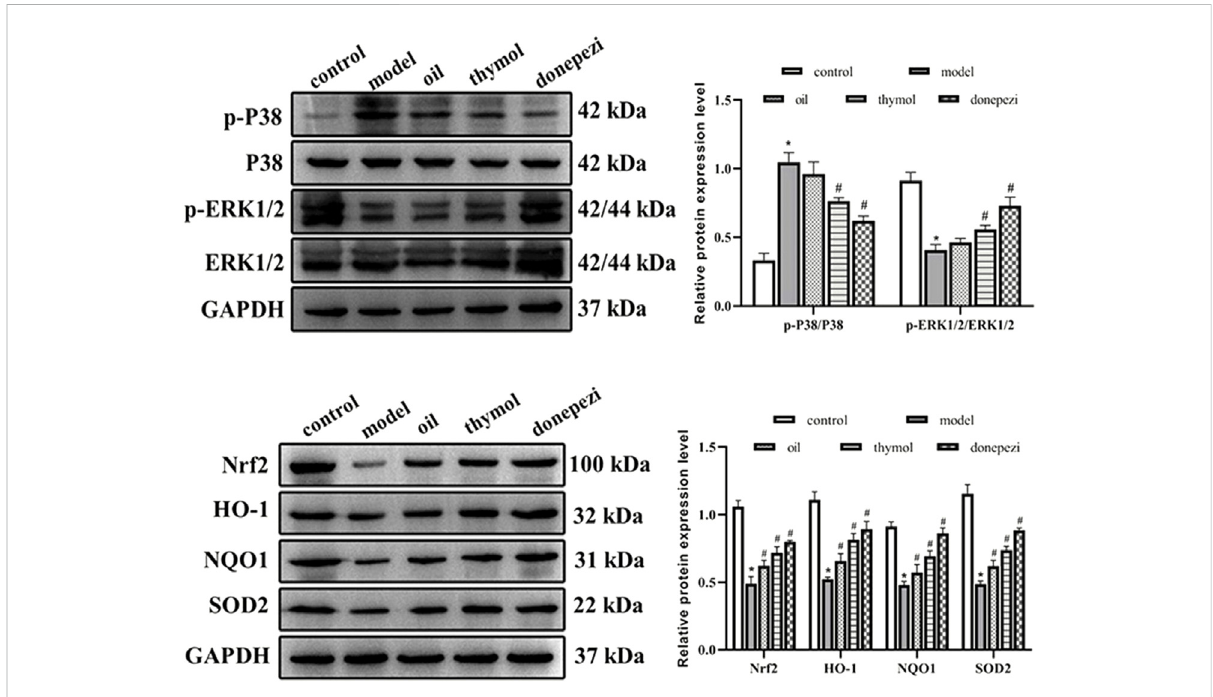
FIGURE 4 Comparison of related proteins expression levels in each group. Compared with control group * p < 0.05; Compared with model group # p < 0.05; compared with donepezil group & p < 0.05 n =